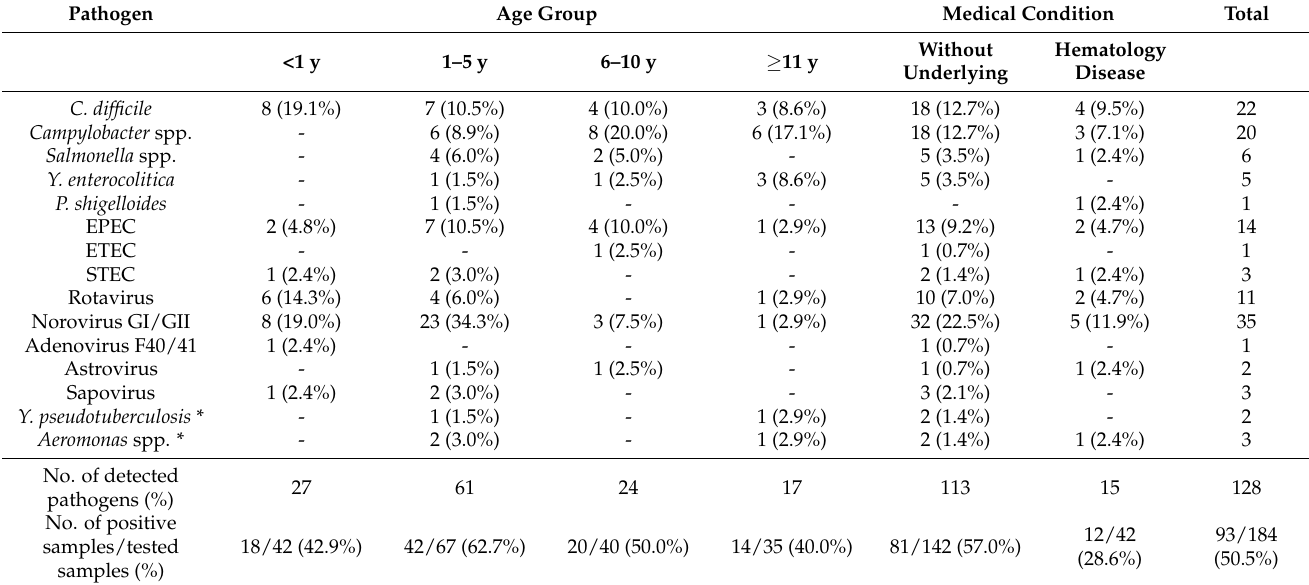
Table 6. Number (%) of pathogens according to age group and medical